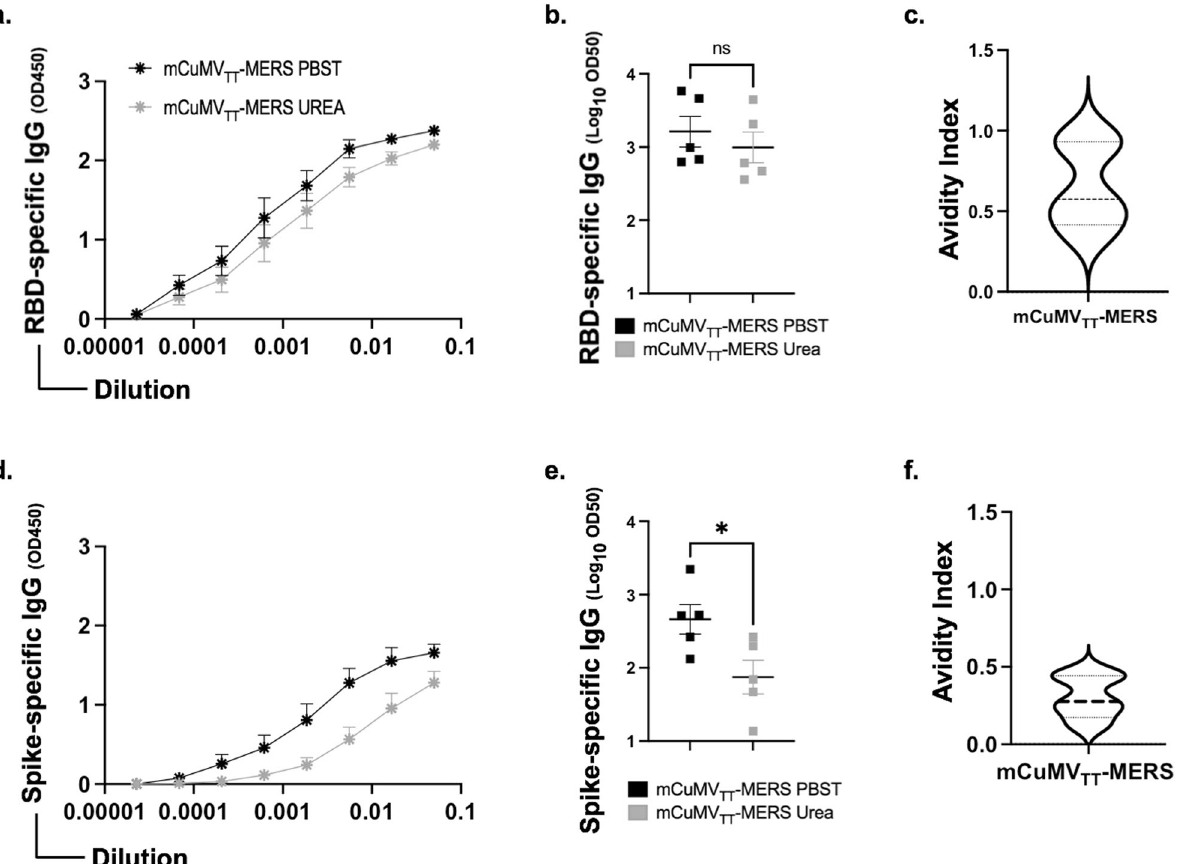
Fig. 5 Induction of high avidity antibodies after vaccination with mCuMV TT -MERS. a , d RBD- and spike speci fi c IgG titer for the group vaccinated with mCuMV TT -MERS vaccine on day 35 measured with OD 450 . After serum incubation one plate was treated with PBS + 0.05% Tween 20 and the other plate with 7 M Urea in PBS + 0.05% Tween 20. b , e Log 10 OD 50 values (mean ± SEM) of RBD- and spike-speci fi c IgG titers (shown in a and d ) for the group vaccinated with mCuMV TT -MERS, ( p value 0.4860 in b and 0.0327 in e ). c , f Avidity index showing the percentage of high avidity RBD- and spike-speci fi c IgG antibodies calculated with the data from ( a ) or ( d ). Statistical analysis using Student ’ s t test. Control group n = 5 and vaccine group n = 5 . One representative of 2 similar experiments is shown. The value of p < 0.05 was considered statistically signi fi cant (* p < 0.01, ** p < 0.001, *** p <